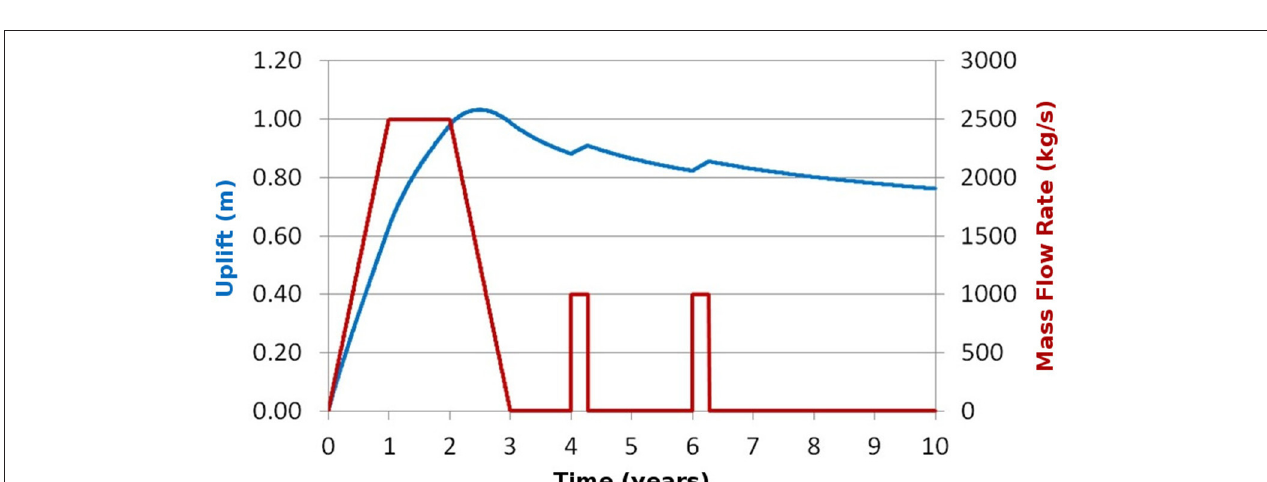
FIGURE 5 | Simulation of two magma inputs. The blue line is the uplift (left axis) over time of the maximum uplift point (center of the sill). The red line represents the mass flow rate over time (right axis).